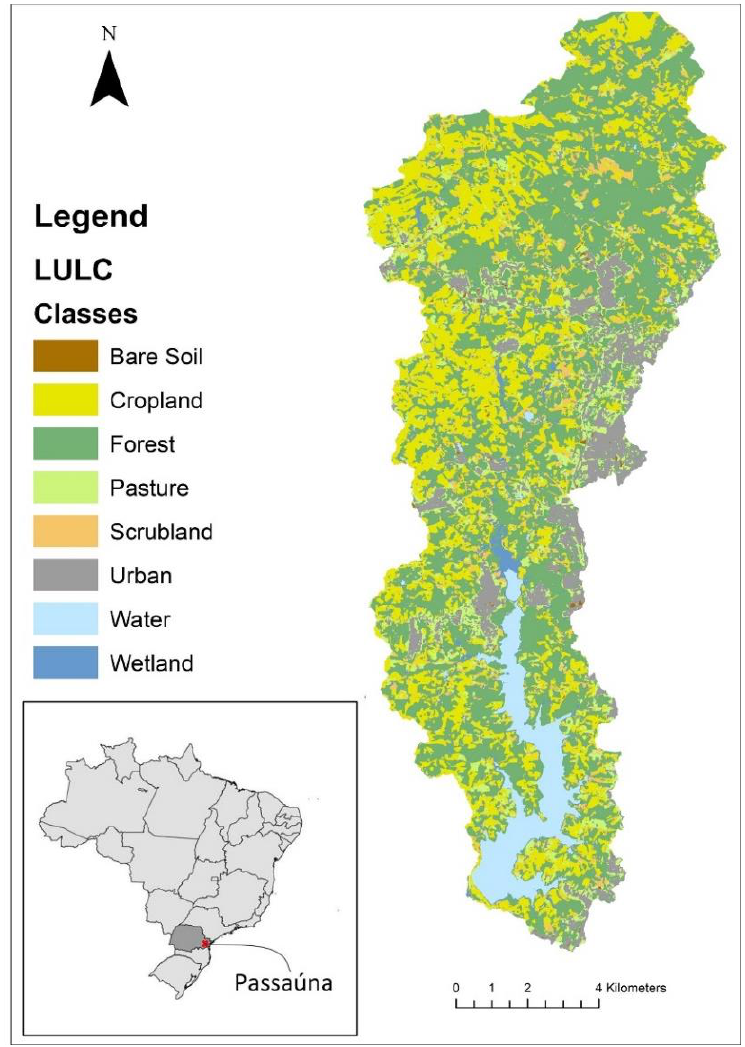
Figure 1. Location of Passaúna catchment in the lower left corner of the graph, and the land use/land cover of the catchment.